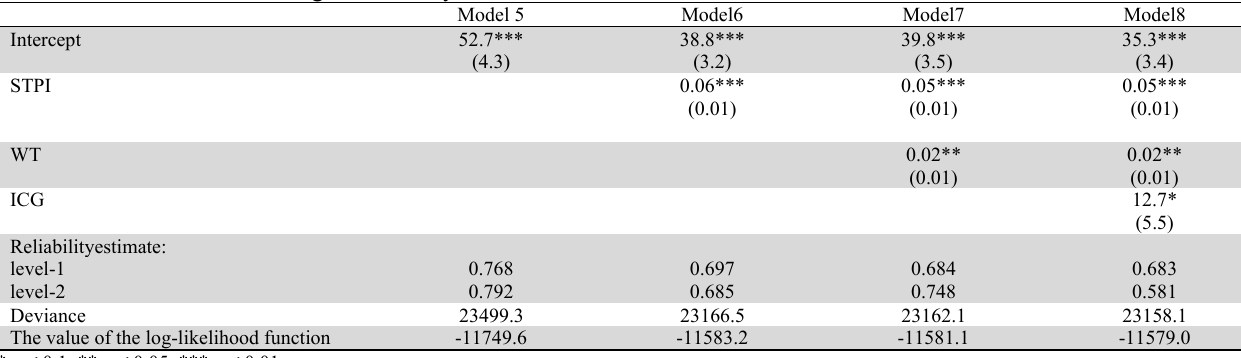
Results of multivariate HLM regression